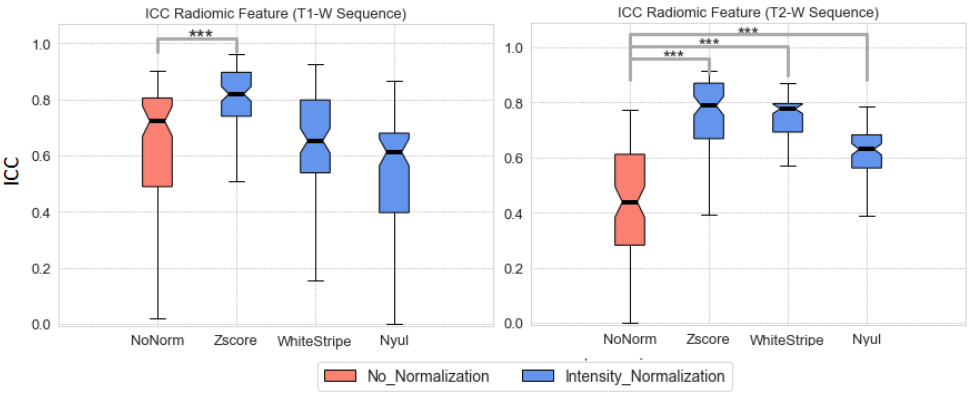
Figure 3. The distribution of ICC values computed from extracted features for non-normalized images and for normalized images with Z-score, WhiteStripe and Nyul methods. *** (significant statical difference).